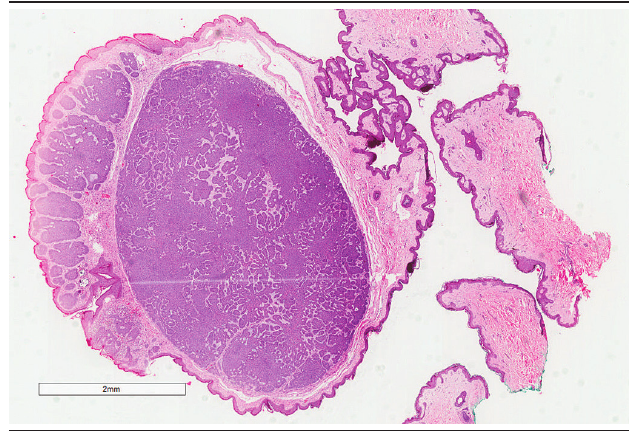
figura 3 − CBC polipoide: histopatologia (HE, 12×) CBC: carcinoma basocelular; HE: hematoxilina e